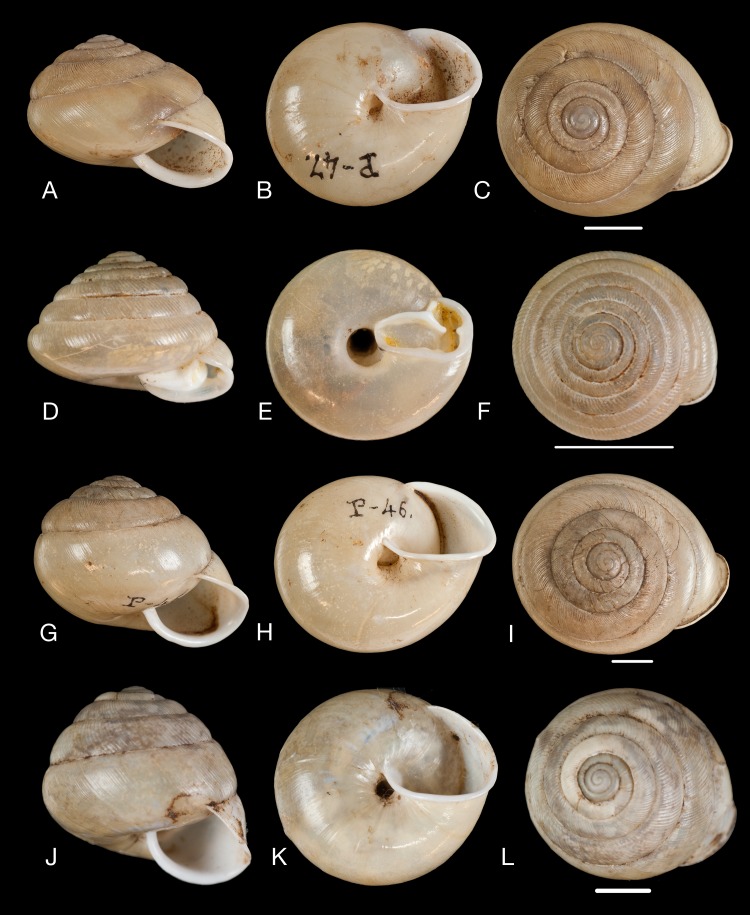
Material collected by the CCP.(A–L) Streptaxidae. Streptaxis contusus (Férussac, 1821), MNCN 15.05/20178, (A) ventral view, (B) umbilical view, (C) apical view; Streptaxis crossei (Pfeiffer, 1867), MNCN 15.05/20177, (D) ventral view, (E) umbilical view, (F) apical view; Streptaxis dunkeri (Pfeiffer in Philippi, 1845), MNCN 15.05/20117, (G) ventral view, (H) umbilical view, (I) apical view; Streptaxis uberiformis (Pfeiffer, 1848), MNCN 15.05/20125, (J) ventral view, (K) umbilical view, (L) apical view. Scale line 5 mm.